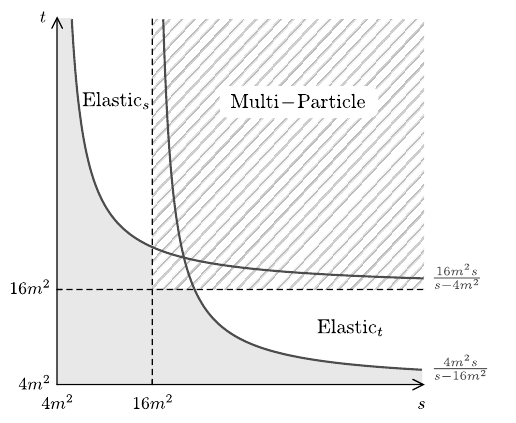
Figure 1: The Landau curves in the elastic region 4 m 2 ≤ s , t < 16 m 2 are known thanks to elastic unitarity. The first of these are plotted in this figure. In the gray region, the double discontinuity is equal to zero. The main purpose of the present paper is to explore the structure of the Landau curves in the multi-particle region s , t ≥ 16 m 2